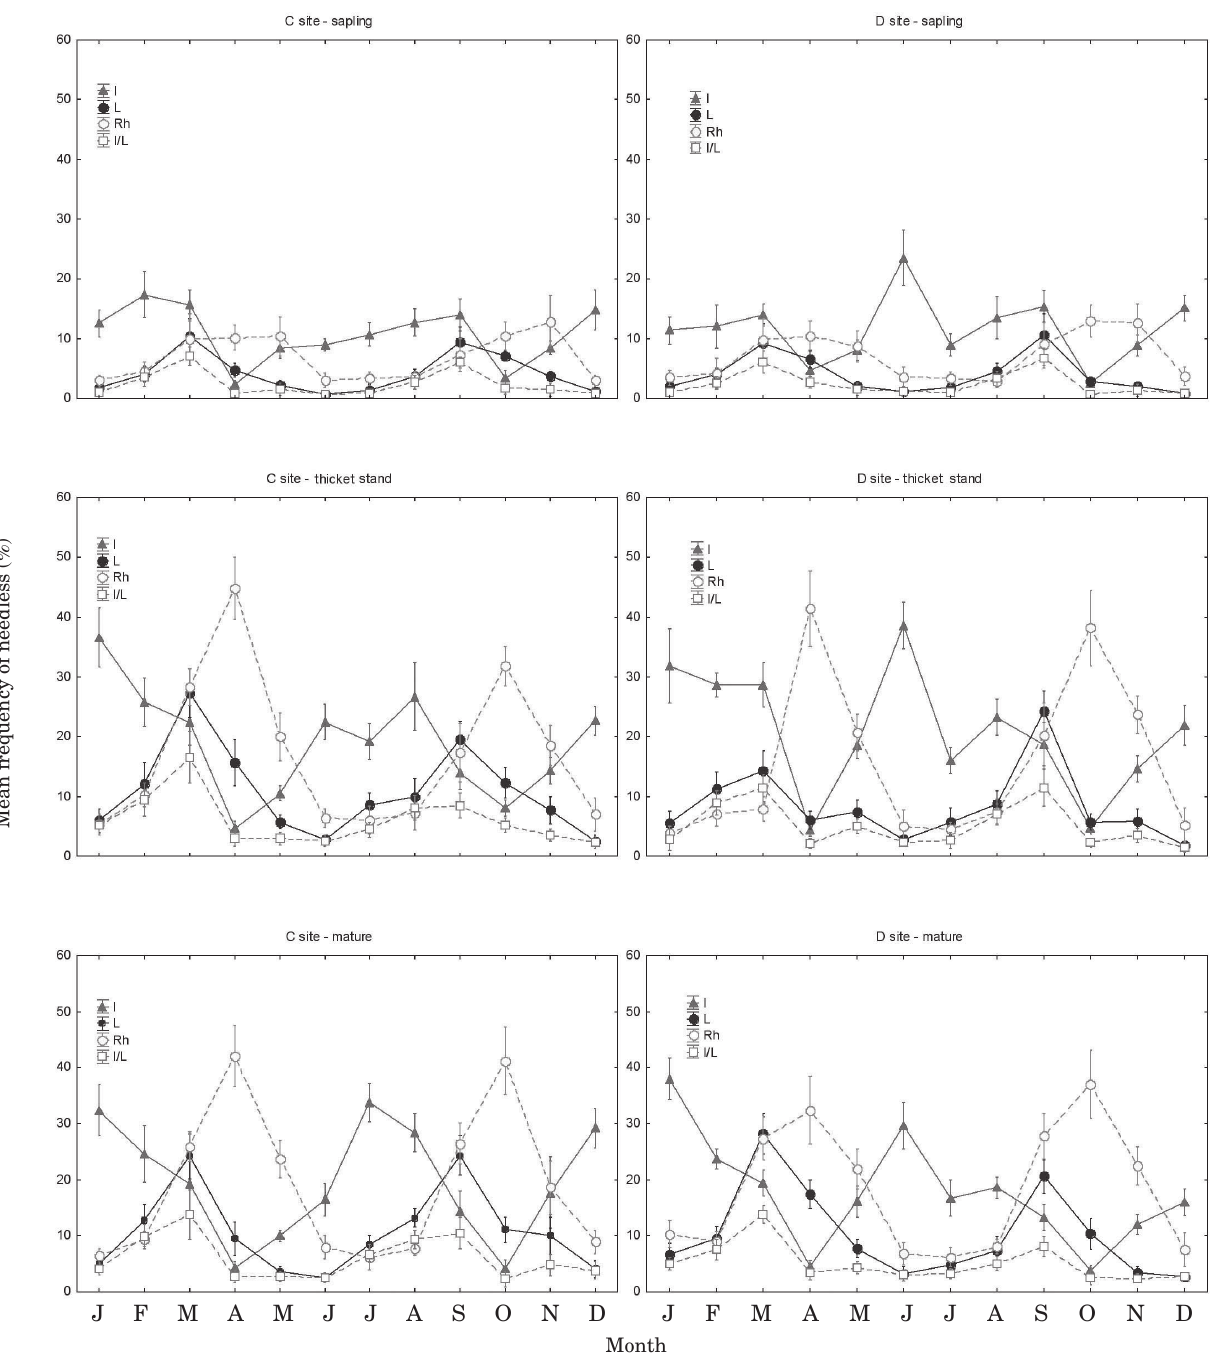
Fig. 3b. Frequency of needles infected with Lophodermium piceae (checked as: conidiomatal stage “l”, ascomatal stage “L”) and Rhizosphaera kalkhoffii (Rh) at sites C and D. Fungal trends are the means of 10 trees in each plot, calculated every two months. The simultaneous occurrence of the conidiomatal and the ascomatal stage of L. piceae is represented by the “l/L” line. The data point values of a month with standard errors ( P <0.05) indicated by whiskers, relate to that and the